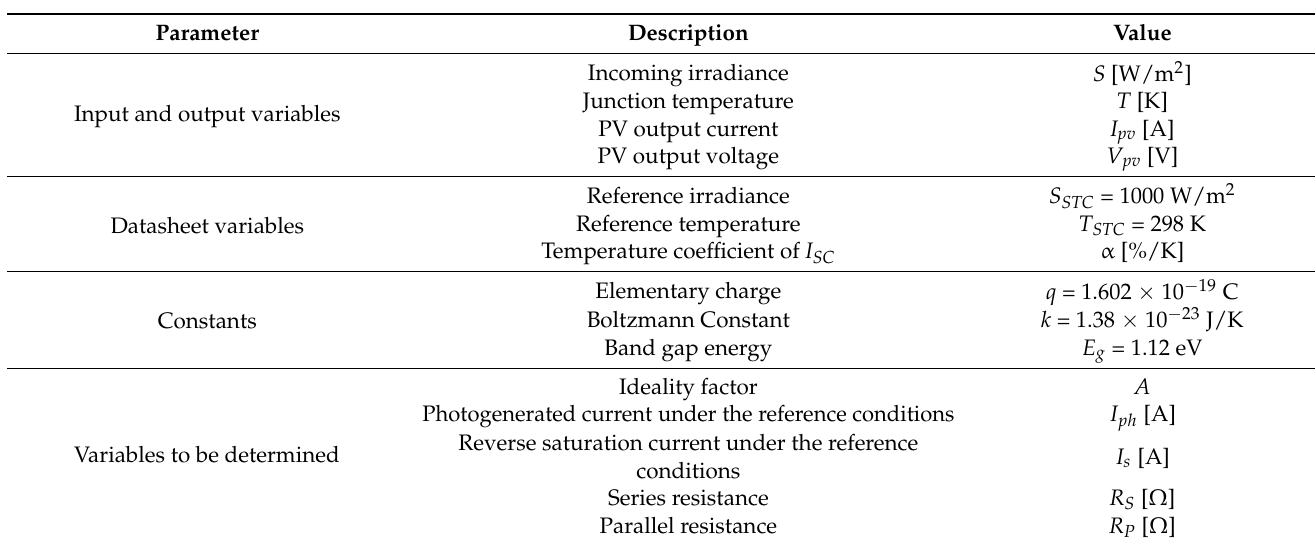
Table 1. Description of the variables from